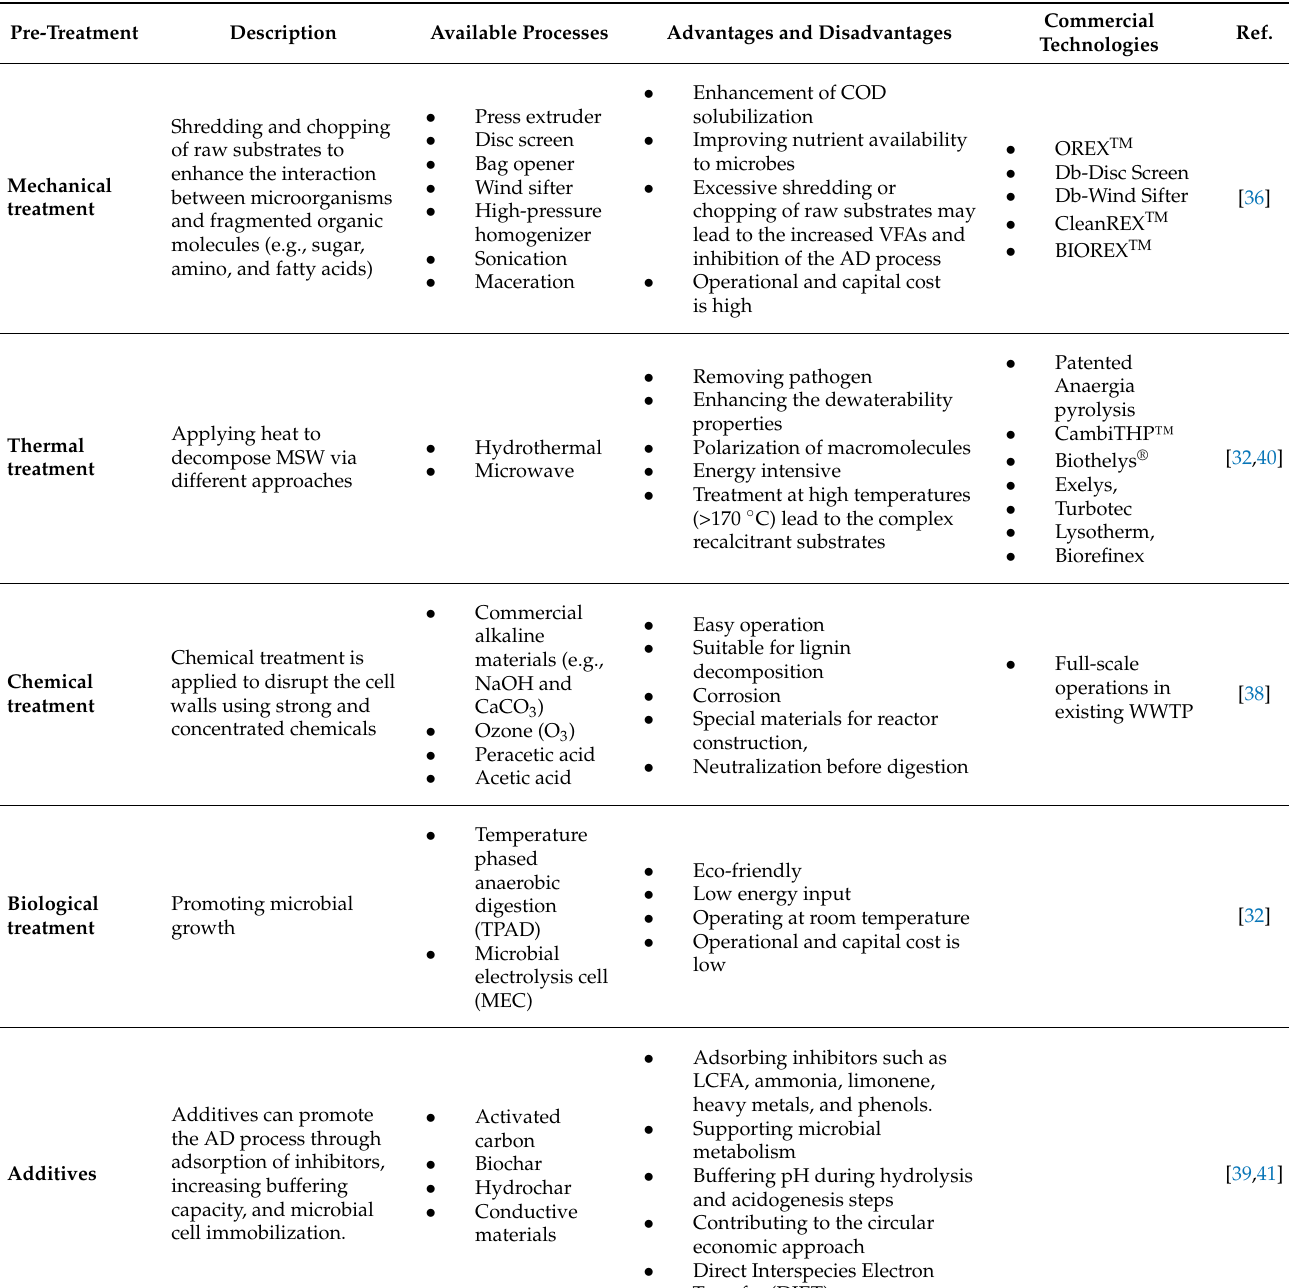
Table 4. Summary of available commercial pretreatment AD technologies along with their advantages and